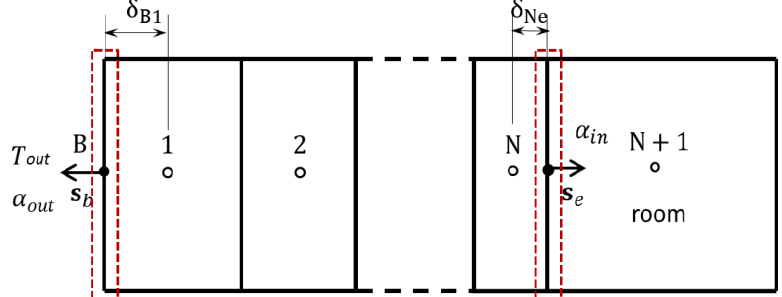
Figure 4. Special calculation of coefficients and source terms for marked surfaces (exposed to ambient— left hand side and at interface outer wall and room— right hand side ).